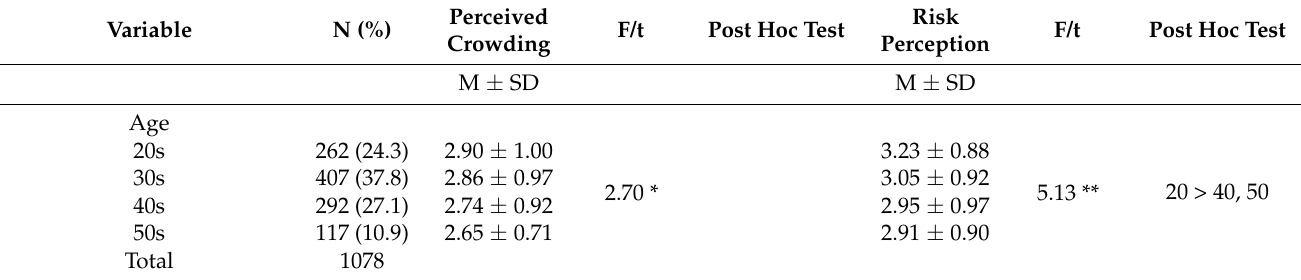
Table 1. Differences in Perceived Crowding and Risk Perception According to Sociodemographic Characteristics (N = 1078). Perceived Variable N (%) Crowding